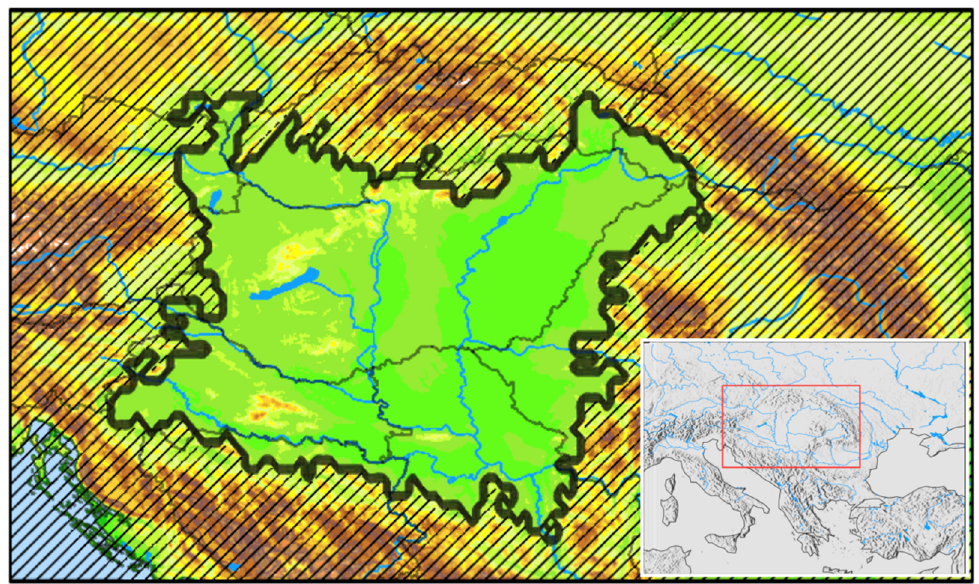
Figure 1. The Pannonian Basin, central valley is indicated as a not-hatched area that is also bounded by the thick black line. In the bottom right corner, the wider Southeast Europe region is given with the red rectangle indicating boundaries of the main figure.